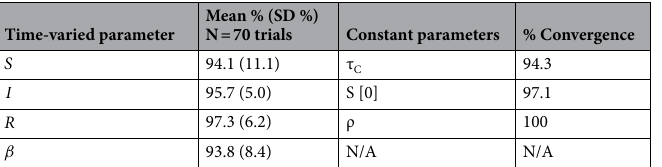
Table 10. Results of testing the JAGS model with convergence percentages. SD standard deviation, N/A not applicable.